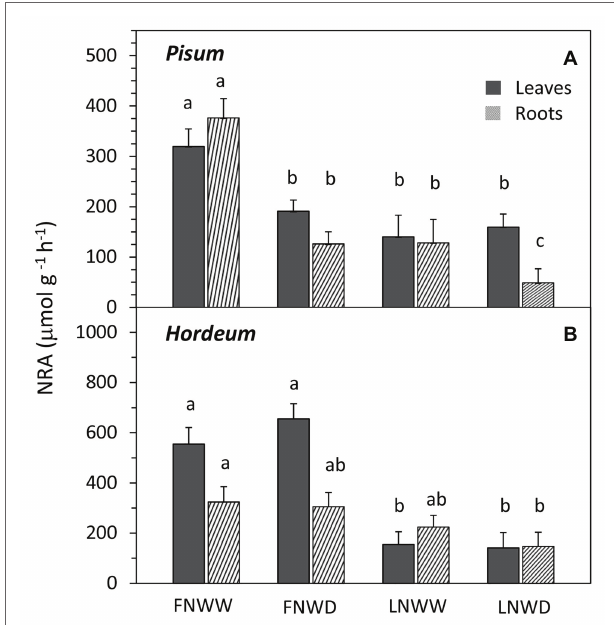
FIGURE 4 | Mean nitrate reductase activity (NRA) in leaf and root biomass of P. sativum (A) and H. vulgare (B) plants after 2–6 days treatment with different water and nitrogen availability. FNWW plants received 4 mM NO3 − daily, FNWD plants received 4 mM NO3 − at the start but no water during the sampling period, LNWW plants received 0.2 mM NO3 − daily, and LNWD plants received 0.2 mM NO3 − at the start but no water during the sampling period. Presented are means ± SE ( n = 6–17). Significant differences ( p ≤ 0.05) between treatments were tested separately for each species and are marked by different letters. FN, full nitrogen; LN, low nitrogen; WW, well- watered; and WD, water